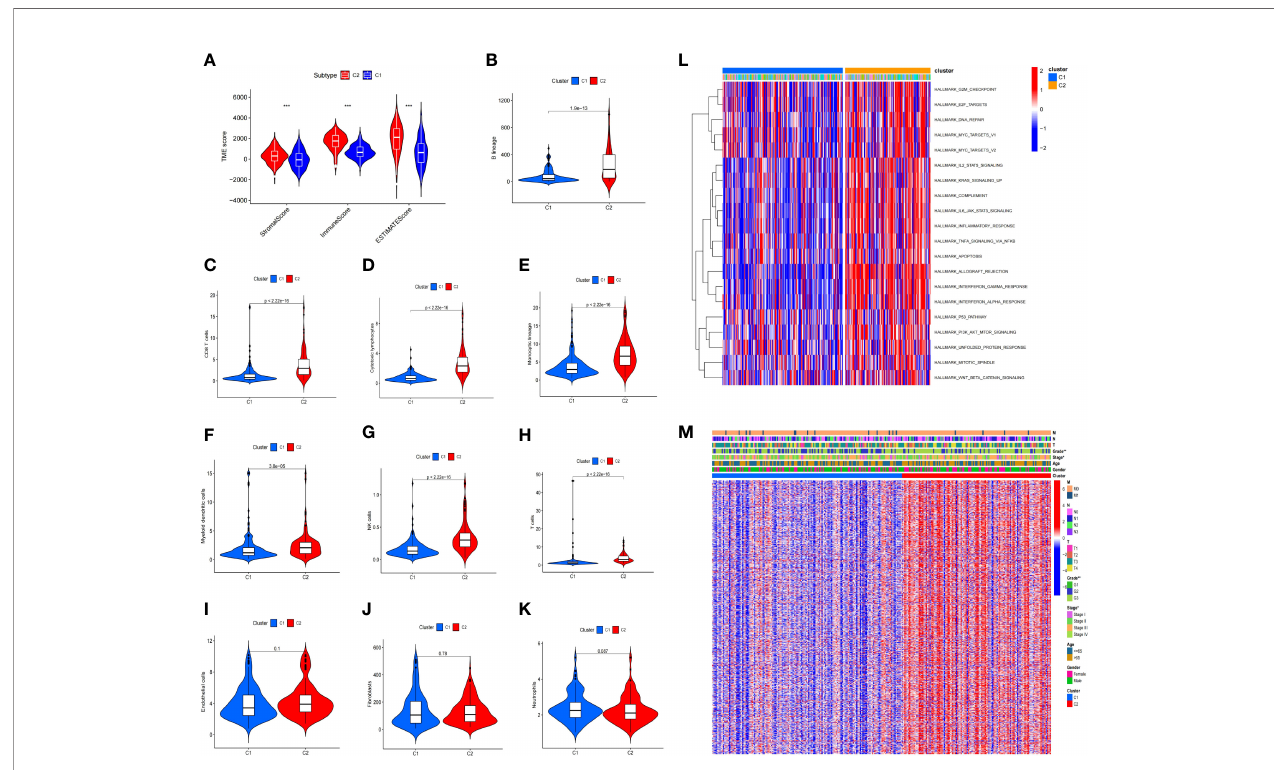
FIGURE 3 | Immune difference between the two clusters. The patients in cluster 2 had substantially higher immunological, estimation, and stromal scores than those in cluster 1 (A) . Furthermore, the abundance of B lineage (B) , CD8 + T cells (C) , cytotoxic lymphocytes (D) , monocytic lineage (E) , myeloid dendritic cells (F) , NK cells (G) , and T cells (H) was signi fi cantly higher in cluster 2 than in cluster 1, while no signi fi cant difference was found for the abundance of endothelial cells (I) , fi broblasts (J) , and neutrophils (K) . Gene set variation analysis of the two clusters (L) . Differences in the clinicopathological characteristics between the two clusters (M) (* p < 0.05, ** p < 0.01, *** p <